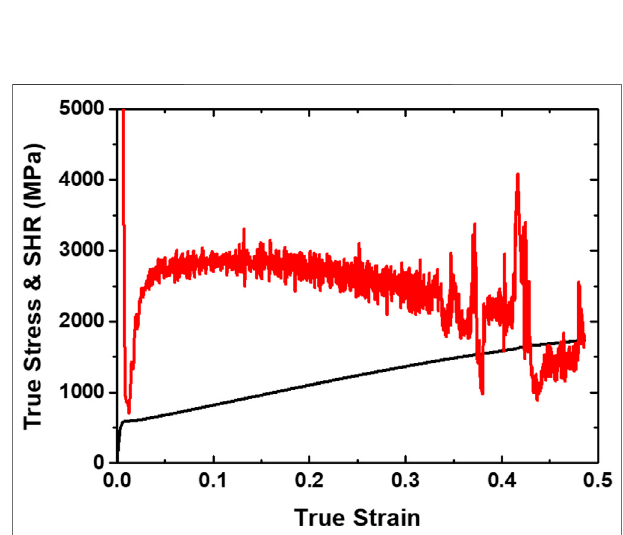
FIGURE 6 | The strain hardening rate (d σ /d ε ) and true stress ( σ ) vs. true strain( ε )curvesoftheFe-18Mn-0.6C-1.5Altwinning-inducedplasticity(TWIP) steel specimen annealed at 700 ° C for 5 min followed by water quenching (WQ).